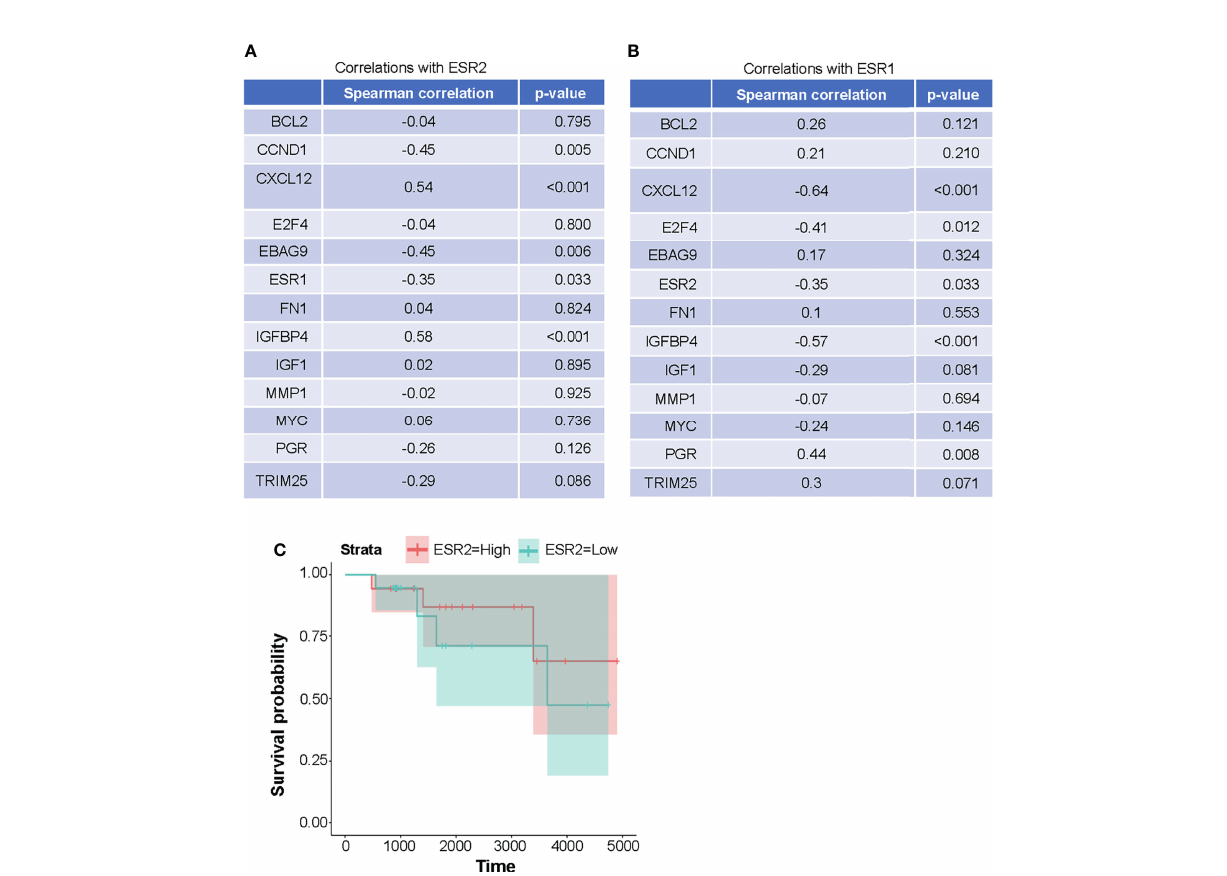
FIGURE 6 | (A, B) Expression of the genes that are targets of ER-AP1-mediated transcription and AP1-independent ERE-mediated transcription in metastatic HER2-negative ER+ breast cancer patients is positively correlated with ESR2 . (A) expression of ESR2 is positively correlated with CXCL12 and IGFBP4 expressions and negatively correlated with CCND1 , EBAG9 , and ESR1 expressions. (B) ESR1 expressions is positively correlated with PGR expressions and negatively correlated with CXCL12 , E2F4, IGFBP4 , and ESR2 expressions. Expression levels (FPKM) and Spearman correlation coef fi cients were computed for ESR1 and ESR2 expressions versus other gene expression levels. (C) Overall survival was not signi fi cantly correlated with the expression of ESR2 in the HER2-negative ER a + metastatic breast cancer patient cohort, although there was a trend toward a positive correlation. ESR2 was dichotomized relative to the median expression level and tested via the log-rank test (p = 0.6). Cox proportional hazards regression on the continuous expression levels yielded similar results (HR 0.6, p =